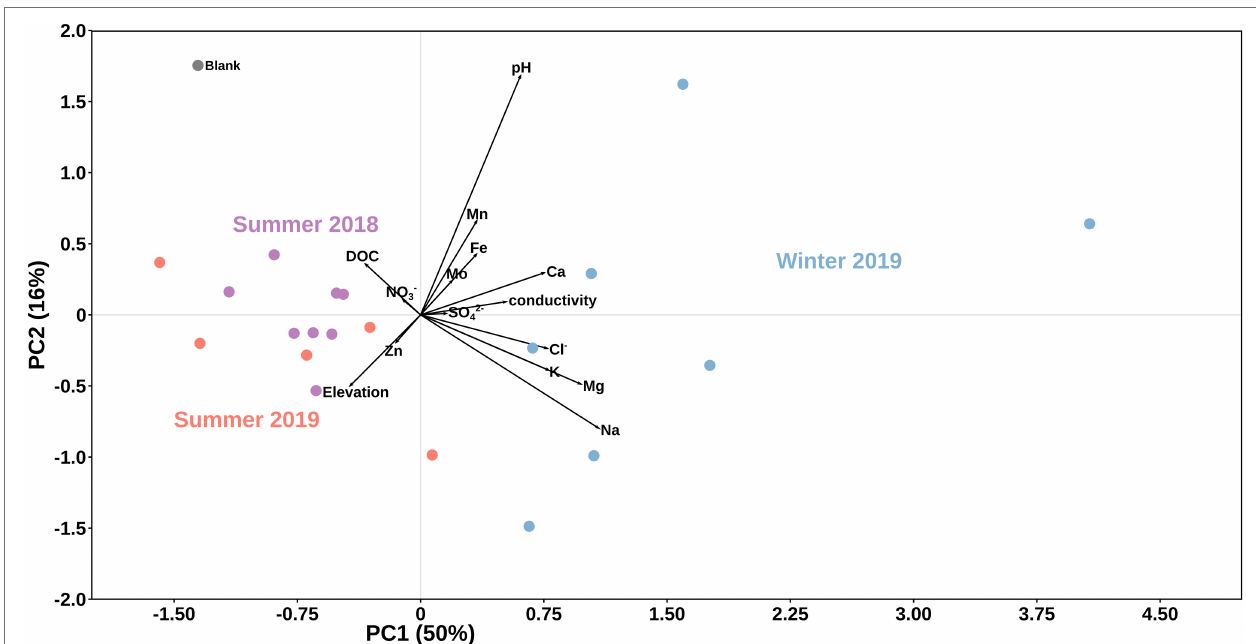
FIGURE 2 | Principal component analysis of data by season. Black vectors indicate environmental/geochemical parameters while differently colored dots represent season of sample collection: purple for summer 2018, light blue for winter 2019, and light red for summer 2019. A field blank of filtered distilled water is shown in